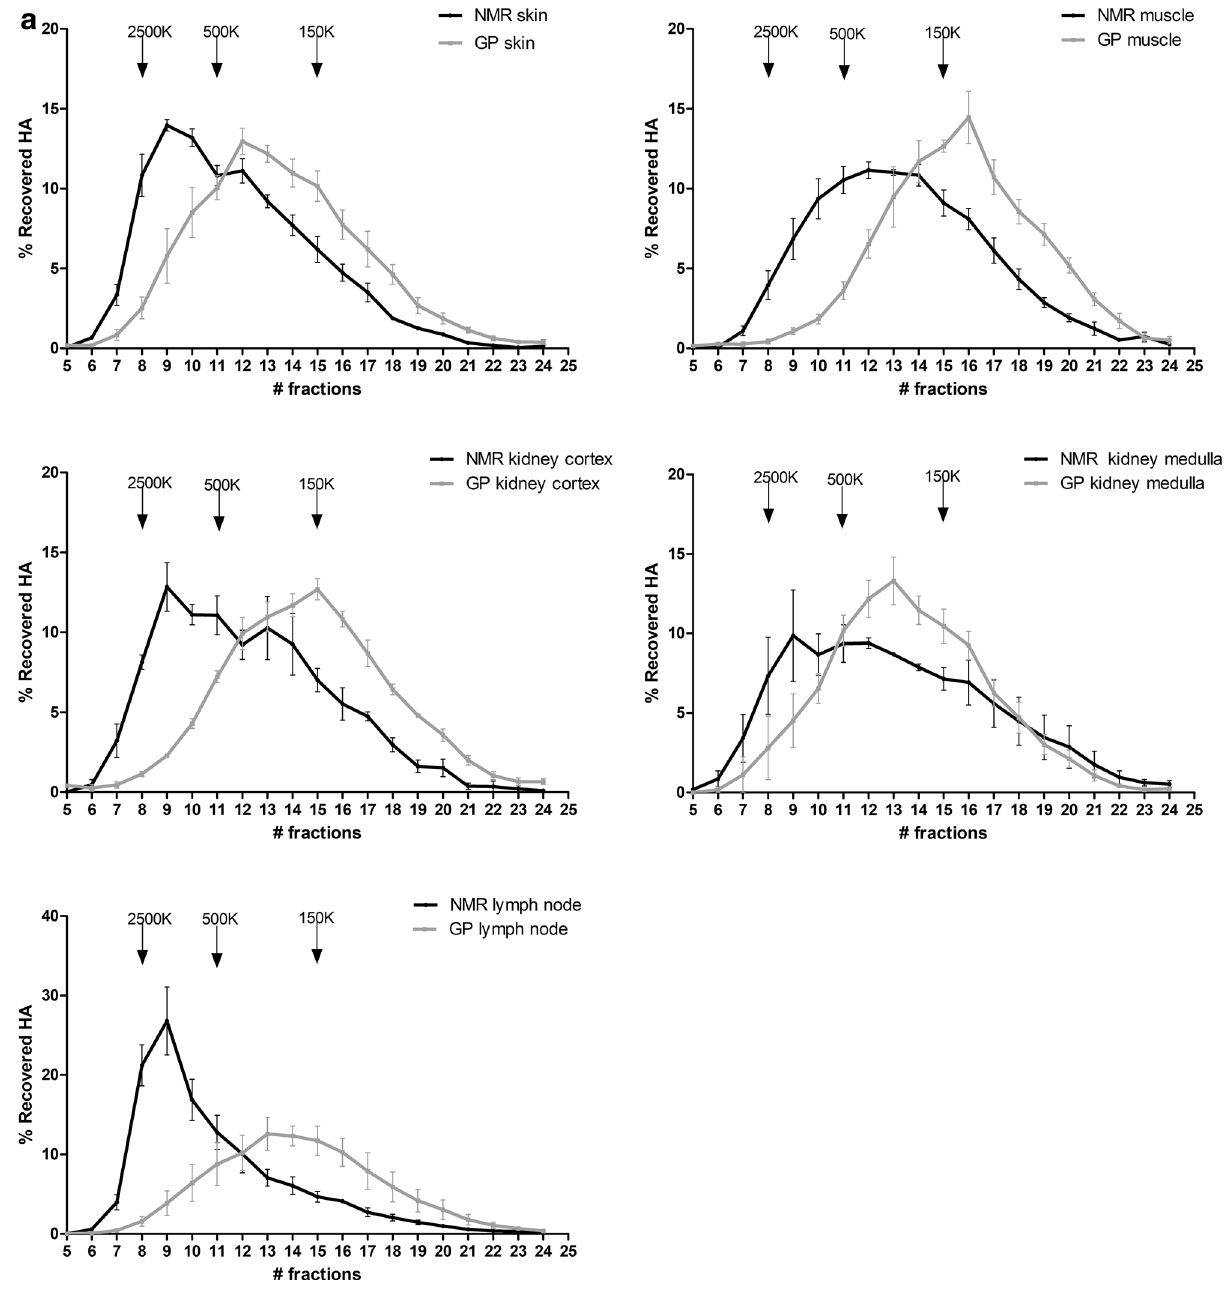
Figure 5. HA molecular weight distribution in NMR and GP tissues, and in NMR, GP, and mouse serum. HA molecular weight in ( a ) NMR (n = 4) vs GP (n = 4) skin, NMR (n = 4) vs GP (n = 4) muscles, NMR (n = 3) vs GP (n = 4) lymph nodes, and NMR (n = 3) vs GP (n = 3) kidney cortex, and NMR (n = 3) vs GP (n = 4) kidney medulla, and ( b ) NMR (n = 11), GP (n = 3) and mouse (n = 4) serum. The elution peaks of three HA standards (2500, 500, and 150 kDa, respectively) are shown by arrows on each graph. ( c ) Ratios of high- (> 500 kDa; HMW) to low- (< 150 kDa; HMW) molecular weight HA in different tissues and the serum of NMR vs GP. Means and SEM are